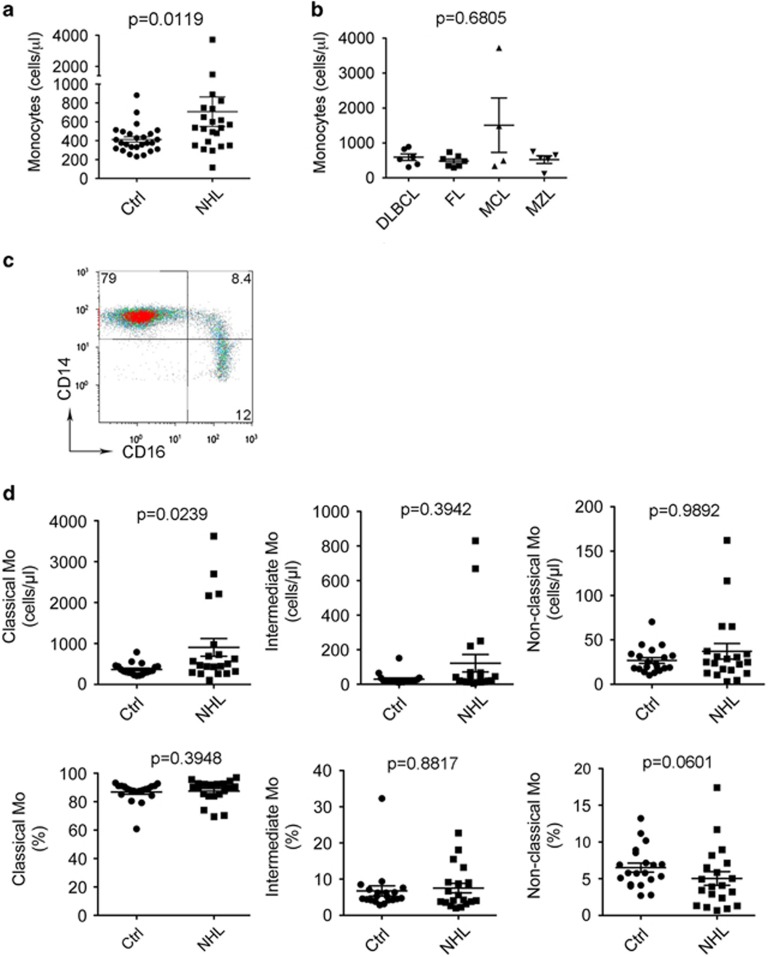
Absolute numbers of monocytes are increased in B-cell NHL. (a and b) A graph showing absolute monocyte counts in blood from NHL patients and healthy donors (a) or patients with different histologies (b) measured by flow cytometry. DLBCL, diffuse large B-cell lymphoma; FL, follicular lymphoma; MCL, mantle cell lymphoma; MZL, marginal zone lymphoma. One milliliter freshly drawn whole blood was stained with a panel of Abs and analyzed by flow cytometry. Absolute monocyte counts were calculated as the numbers of CD14+ cells per microliter of blood (NHL: n=22, Ctrl: n=26). (c) Representative plots showing coexpression of CD14 and CD16 in blood from a healthy donor. Classical monocytes: CD14++CD16−; intermediate monocytes: CD14++CD16+; non-classical monocytes: CD14+CD16++. (d) Graphs showing the absolute counts (upper panel) or percentages (lower panel) of classical, intermediate and non-classical monocytes (Mo) in blood from NHL patients and healthy donors measured by flow cytometry.